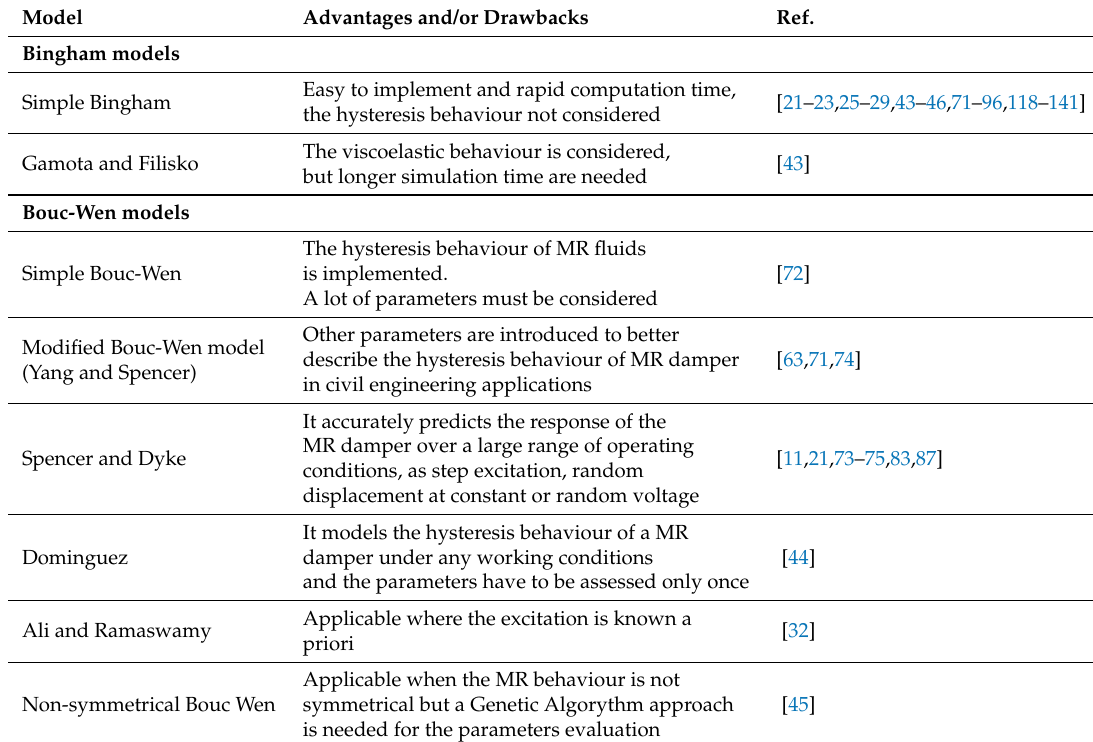
Table 5. Main parametric dynamic models of MR